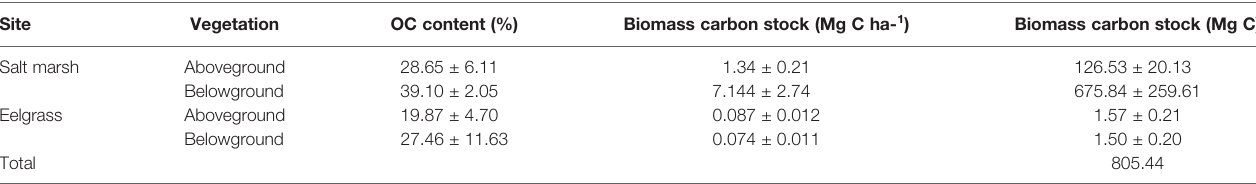
TABLE 3 | Total organic carbon (OC) stocks in salt marsh and eelgrass plant